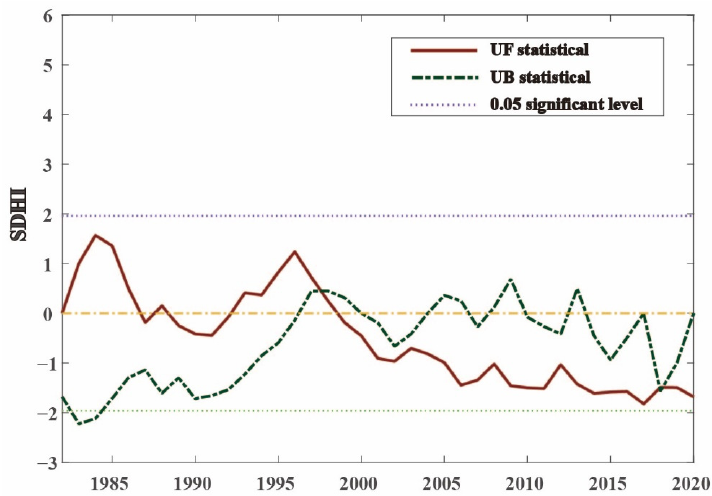
Figure 3. Mutation analysis of SDHI in Inner Mongolia from 1982 to 2020.